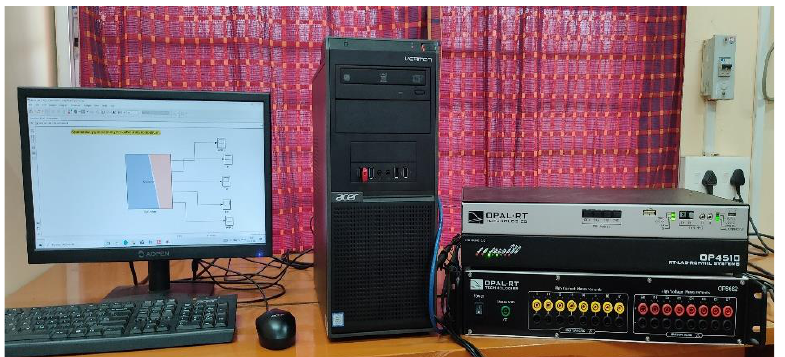
Figure 13. OPAL-RT lab setup with host PC.